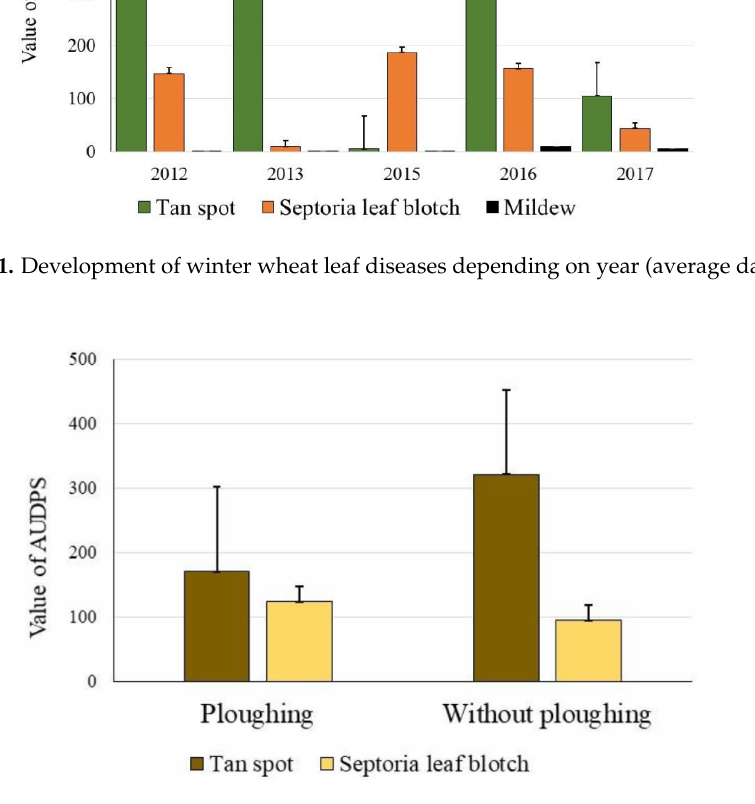
Figure 2. Development of tan spot and Septoria tritici blotch depending on soil